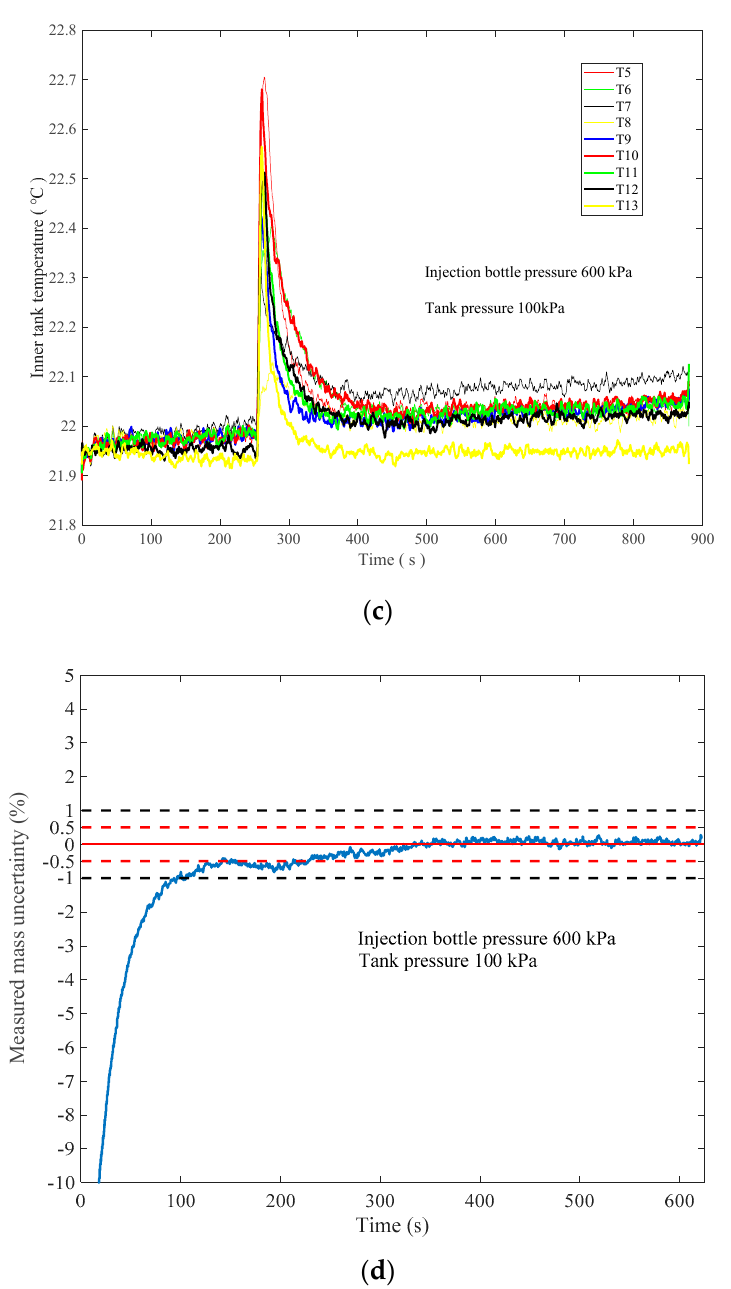
Figure 6. Mass gauge process: ( a ) pressure, ( b , c ) temperature, and ( d ) calculated uncertainty.